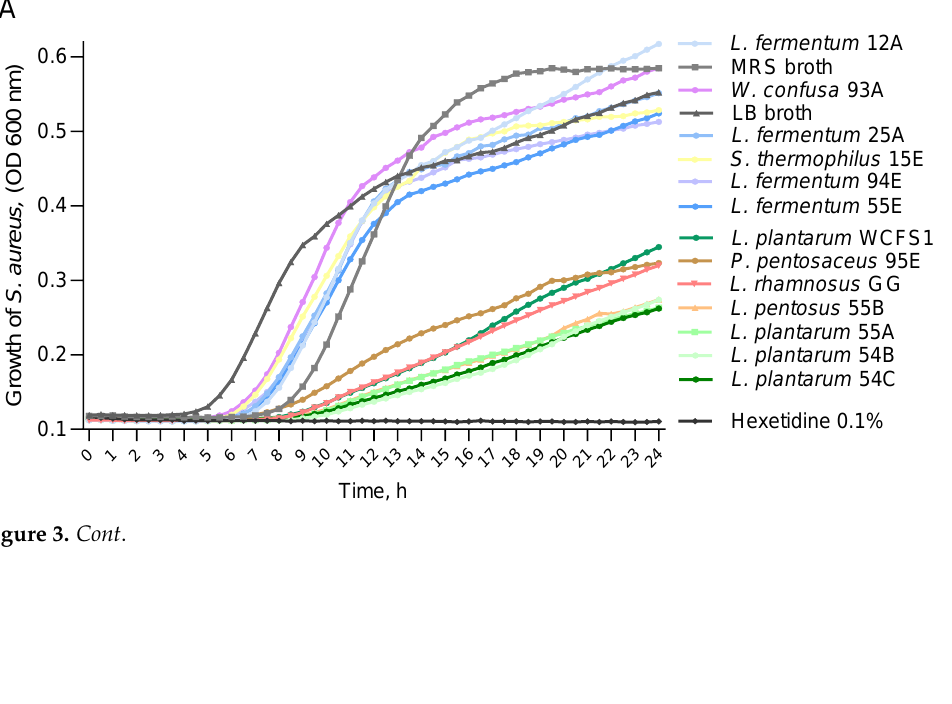
Figure 3. Effect of the LAB strains cell-free culture supernatant (CFS) against the growth of S. aureus MI/1310/1938 in LB broth: ( A ) Growth curves of S. aureus over the course of 24 h, non-inoculated MRS and LB broth and 0.1% hexetidine were used as negative and positive control, respectively. Curves of the most active four LAB strains ( L. plantarum 54B, 54C, 55A, and L. pentosus 55B) are below the curves for the model probiotics ( L. rhamnosus GG and L. plantarum WCFS1), indicating isolates were strong inhibitors. Curves for 95E and model probiotics are overlapping since 95E showed comparable inhibitory activity against the pathogen as model probiotics. ( B ) Area under the curve (AUC) of S. aureus growth curves. Bars depict AUC means ± SD per condition ( n = 3). 55E and 94E have large AUC since they are weak inhibitors. * p < 0.05, *** p < 0.001, **** p < 0.0001 com- pared to S. aureus grown with MRS broth control. L. plantarum , Lactiplantibacillus plantarum ; L. pen- tosus , Lactiplantibacillus pentosus ; L. fermentum , Limosilactobacillus fermentum ; P. pentosaceus , Pediococ- cus pentosaceus ; S. thermophilus , Streptococcus thermophilus ; W. confusa , Weissella confusa. 3.4. Selected Ethiopian Dairy LAB Isolates Activate NF- κB and IRF Pathways in Human Monocytes Immunomodulation is one of the potential mechanisms of action of probiotics. In this study, the eleven selected LAB strains were further explored for their capacity to stimulate the NF- κB and IRF pathways as key for antipathogenic defenses in human monocytes . Nine out of the eleven tested LAB isolates significantly ( p < 0.05) induced NF- κB, while S.